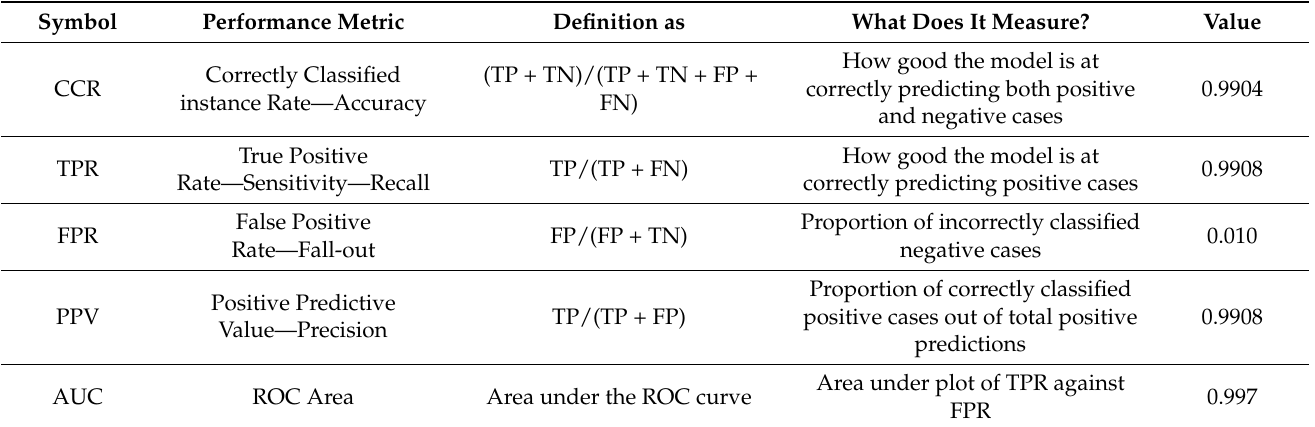
Table 5. Performance metrics of the meta-classifier on test